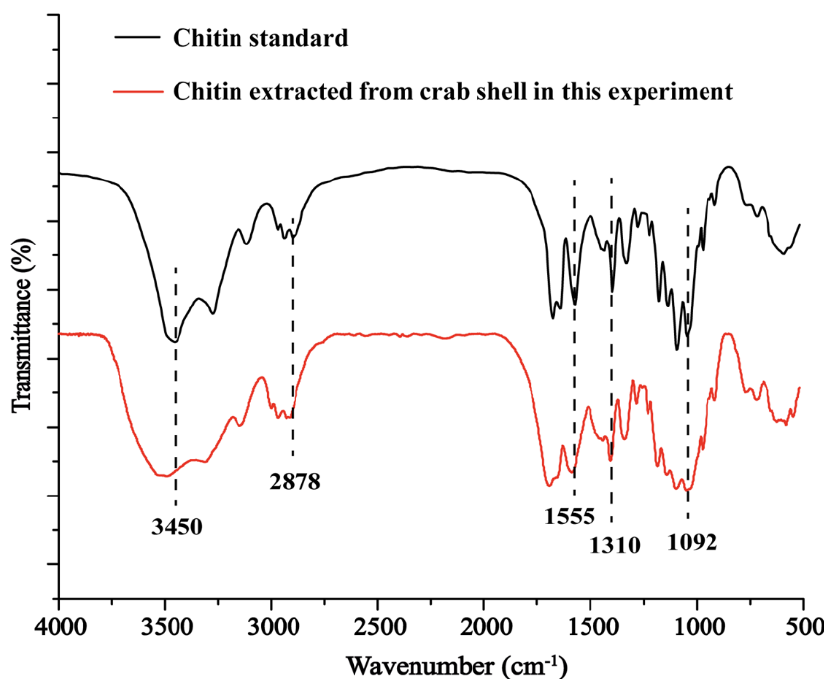
Figure 1. FTIR analysis of chitin extracted from crab shell.